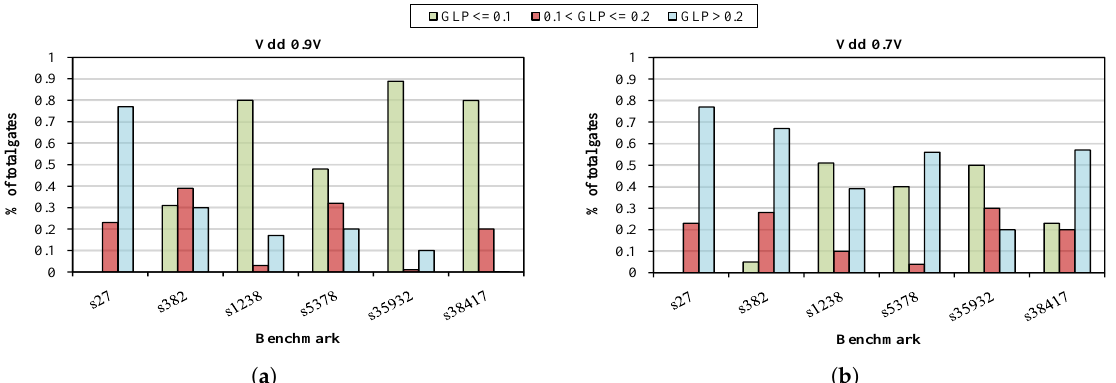
Figure 6. Distribution of gate sensitivity for 6 benchmarks with supply voltage ( a ) 0.9V and ( b ) 0.7V.